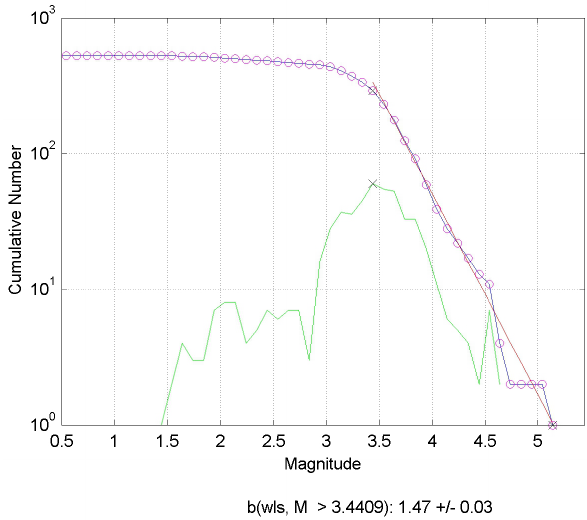
Fig. 6. The maximum of the derivative of the frequency magnitude distribution of the declustered catalogue is used to determine the magnitude of completeness (green curve) and the b-value is deter- mined by the weighted least squares method (red curve).